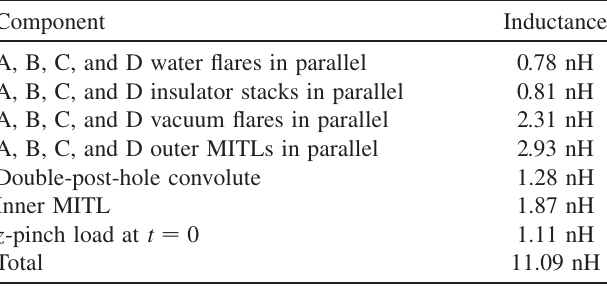
TABLE I. Inductances of the components of the Z -accelerator stack-MITL system. The inductances assume that the fractions of the total outer-MITL current that flowed in levels A, B, C, and D were 0.28, 0.27, 0.23, and 0.22, respectively. We define the inductance of a water flare to be that due to the impedance of the flare that is in excess of the impedance of the set of nine parallel bi-plate transmission lines that drove each level. For each of the other components, the inductance given is the total inductance, without any correction. The initial load inductance is that for a z -pinch load with a 2-cm height, 2-cm initial radius, and 2.5-cm- radius outer electrode with nine diagnostic slots.